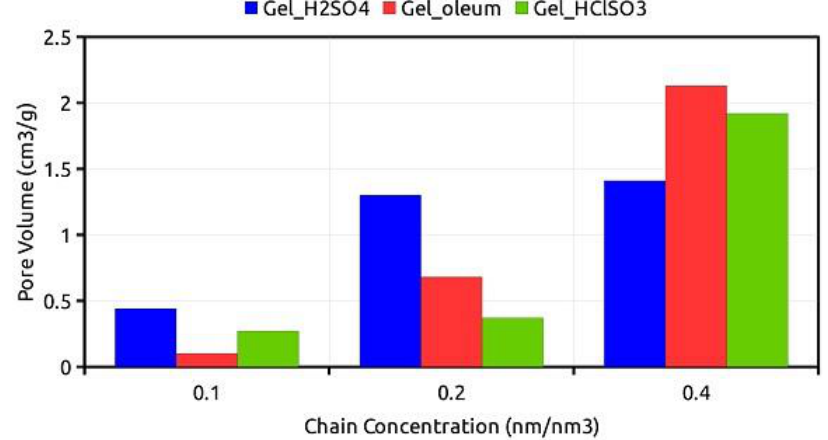
Figure 1. Distribution of the polymer chain concentration of Gel_H 2 SO 4 , Gel_oleum and Gel_HClSO 3 , according to ISEC.